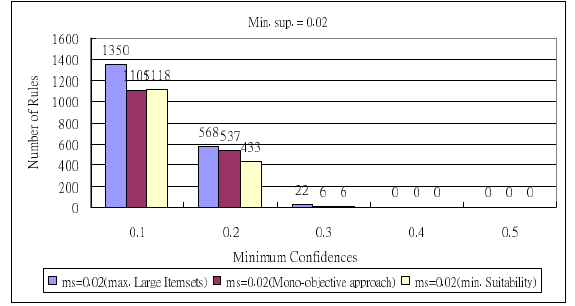
Fig. 10. The number of rules derived by the proposed approach for the uniform dataset